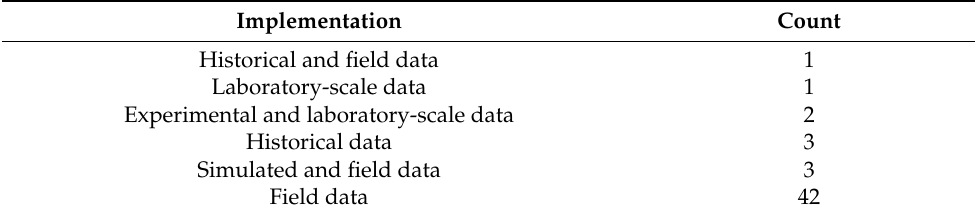
Table 1. Summary of implementation of machine learning